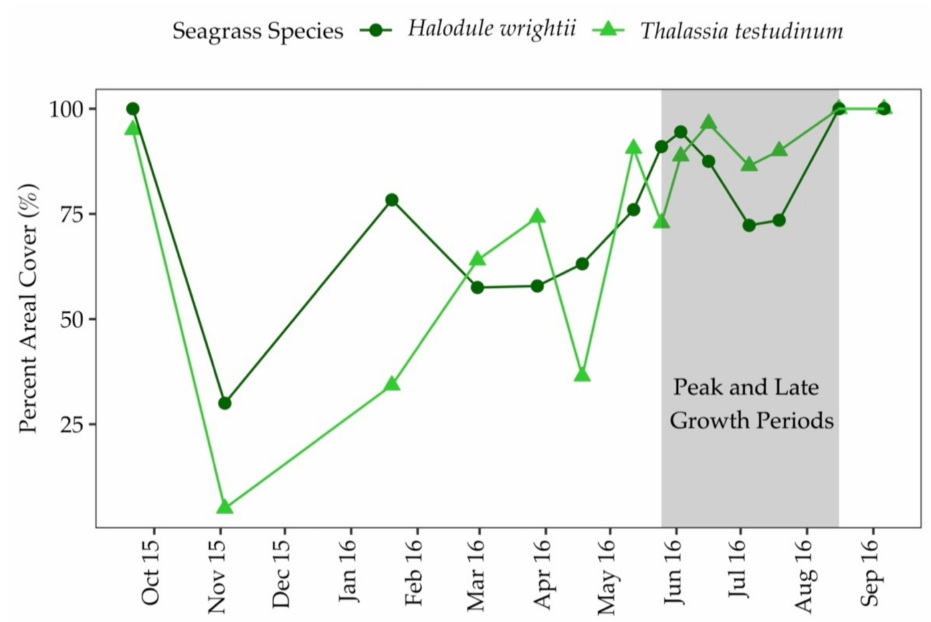
Figure 3. Percent areal cover for both seagrass species, T. testudinum and H. wrightii , between September 2015 and September 2016 at Big Sabine Point.